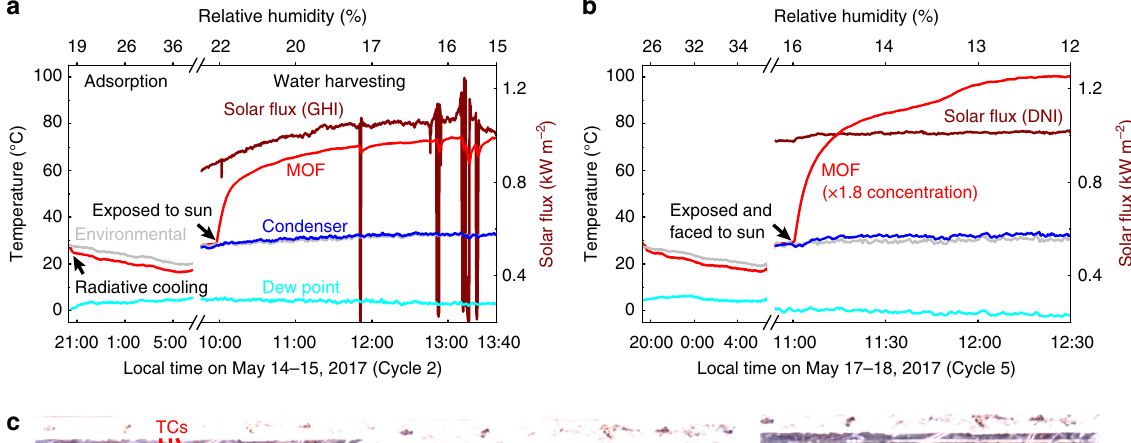
Results from inductively coupled plasma-mass spectroscopy (ICP-MS) analysis indicate that the zirconium (metal ion of MOF-801) concentration in the water was found to be less than 1 ppb (parts per billion) as shown in Supplementary Fig. 12. In addition, the harvested water was analysed using infrared